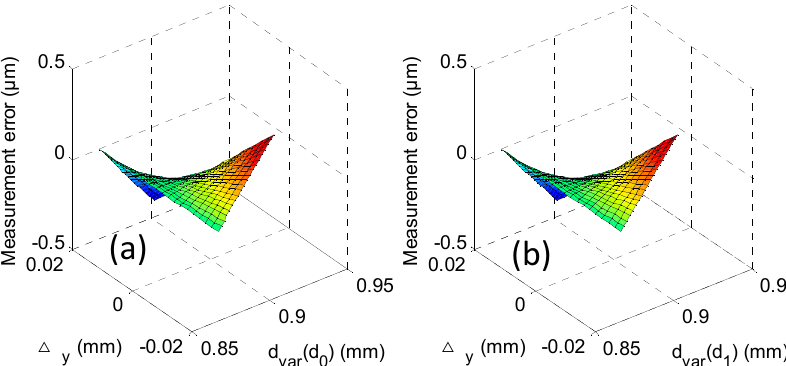
Figure 6. Measurement errors along the Y-axis with different d var values and actual shift value Δ Y along the Y-axis for a point source: ( a ) variation of d var with d 0 , and ( b ) variation of d var with d 1 .